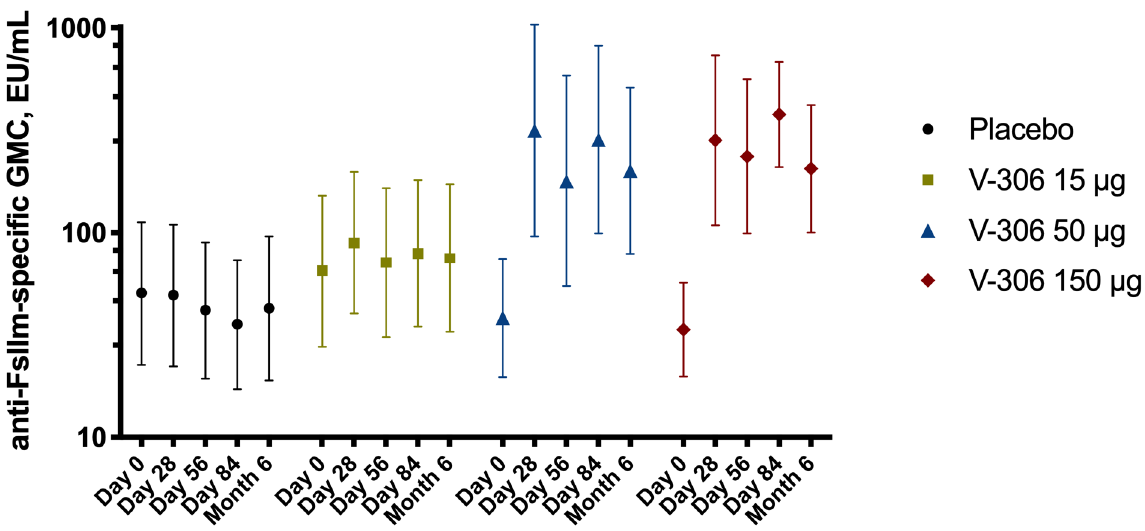
Figure 3. Evolution over time of anti-RSV F protein antigenic site II (FsIIm)-specific immunoglobulin G geometric mean concentrations (GMCs ± 95% confidence interval [CI]) from baseline (Day 0 pre-vaccination) up to Month 6 (4 months after second administration) in the pooled placebo and three V-306 vaccine groups (15 µg, 50 µg, and 150 µg).